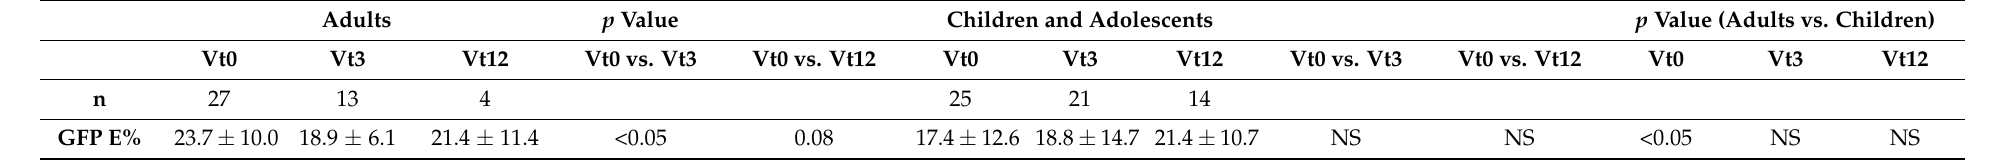
Table 4. GFP energy contribution to total energy intake among celiac adults and children (mean ± SD).